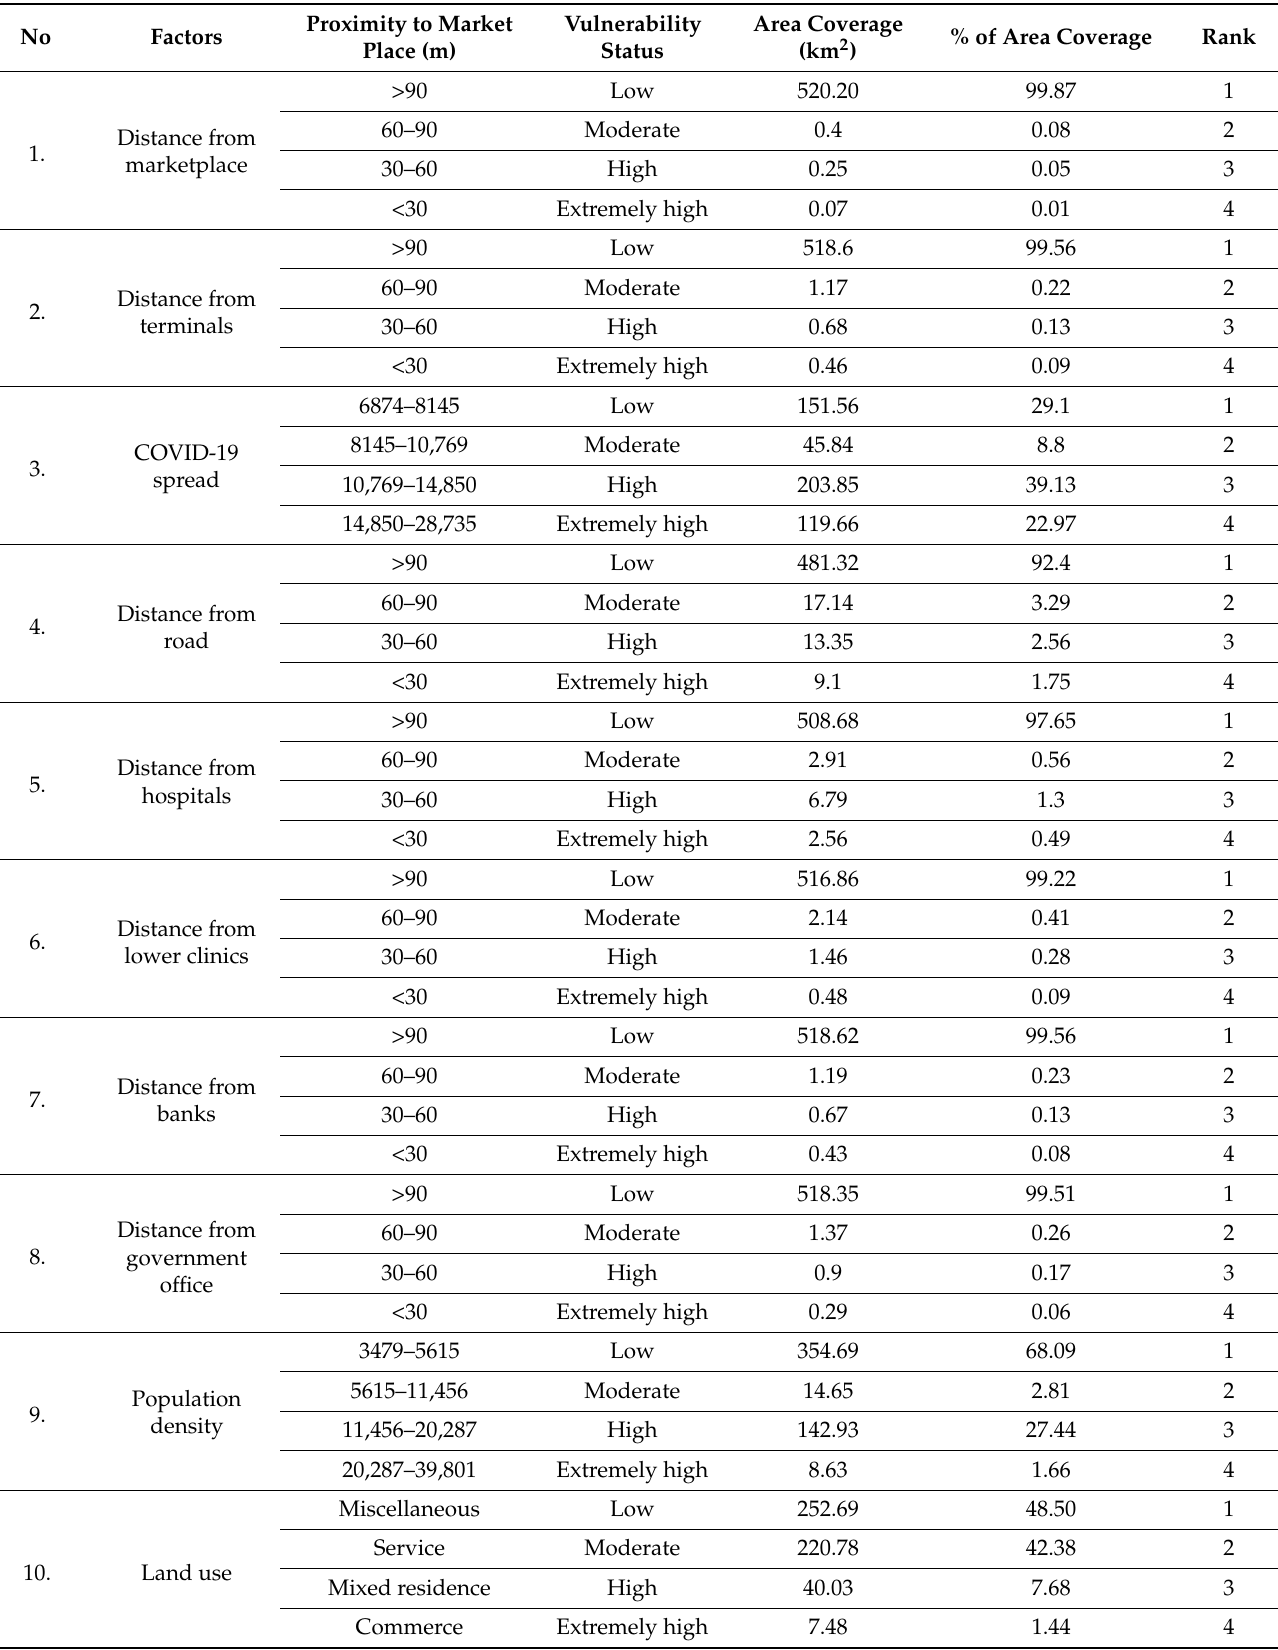
Table 6. Reclassified parameters and area coverage of vulnerability